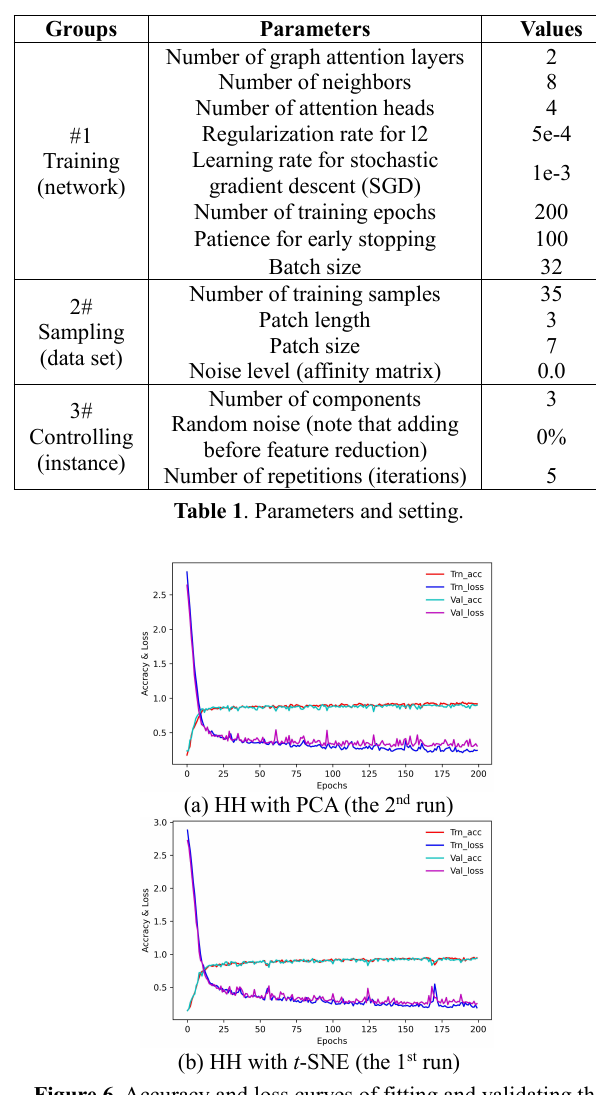
Figure 6 . Accuracy and loss curves of fitting and validating the designed GAT model using the HH data set.